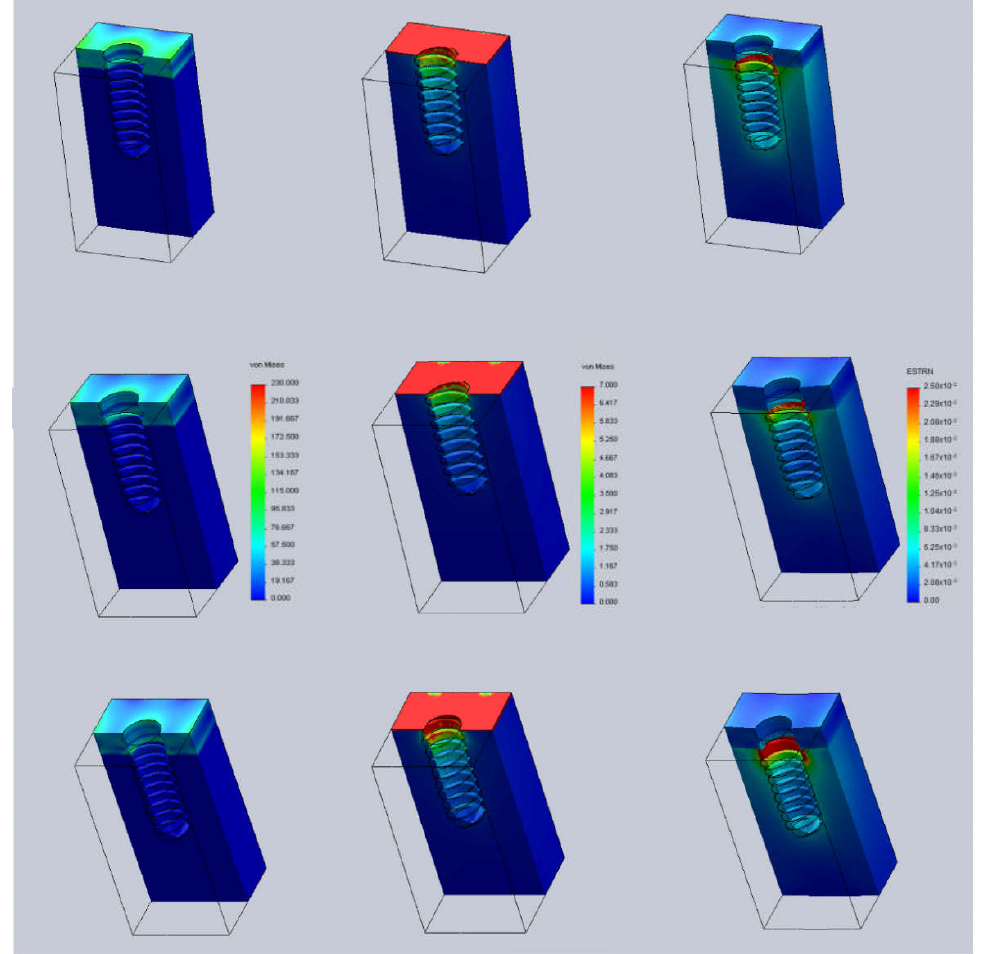
Figure 5. Von Mises stresses (MPa) and strains (mm/mm) with a cortical-bone thickness of 2.5 mm. Left column: stresses at cortical bone. Center column: stresses at trabecular bone. Right column: strains. Top row: Case A (h = +0.5). Middle row: Case B (h = 0). Bottom row: Case C (h = −0.5).